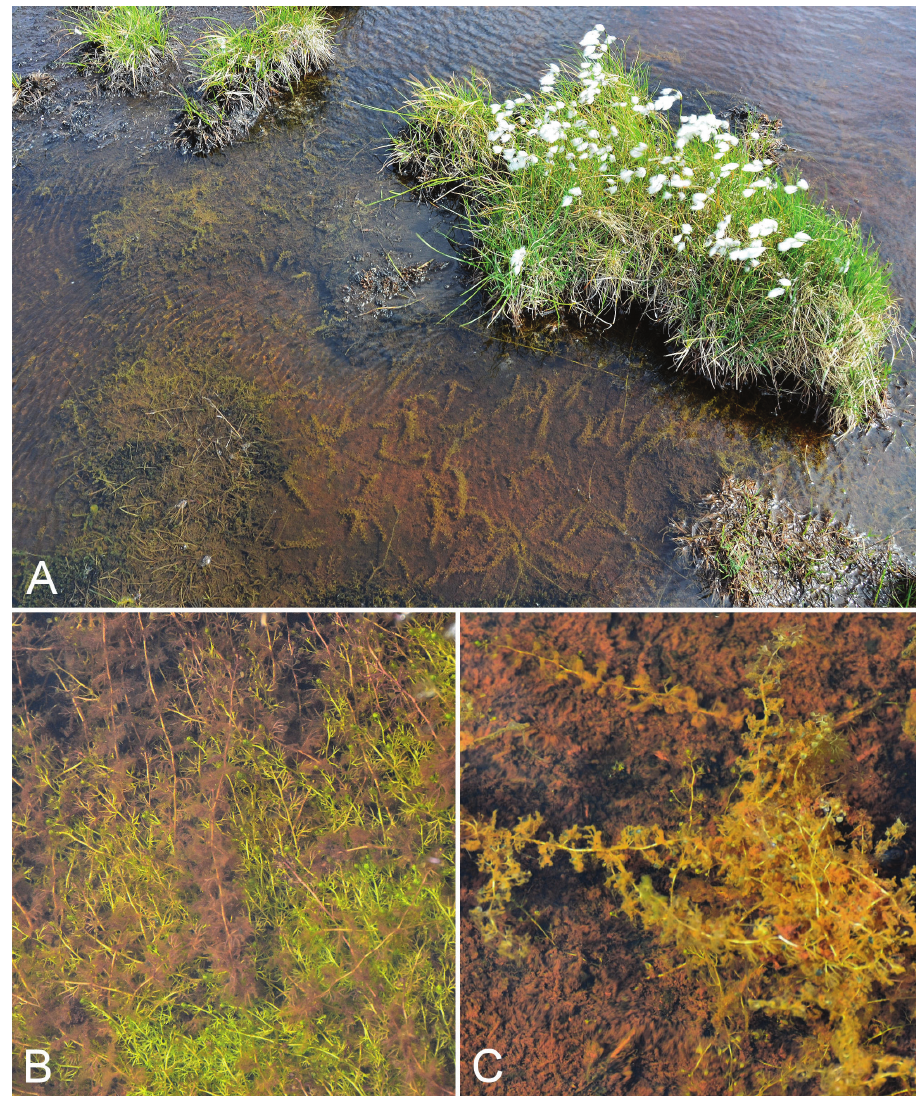
Figure 16. Utricularia ochroleuca : A habitat B habit C habit showing branches with bladders, Saarela et al. 2464 . Photographs by R.D.